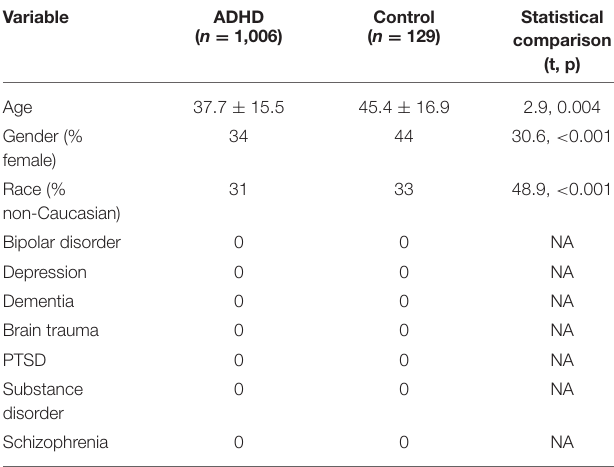
TABLE 1 | Demographic characteristics of Group